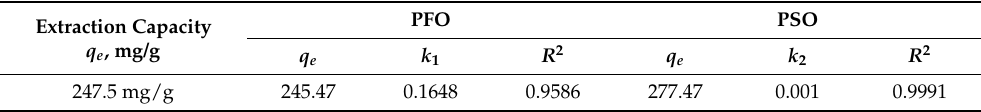
Table 1. The kinetic constants of U(VI) ion extraction by HTIP chelating